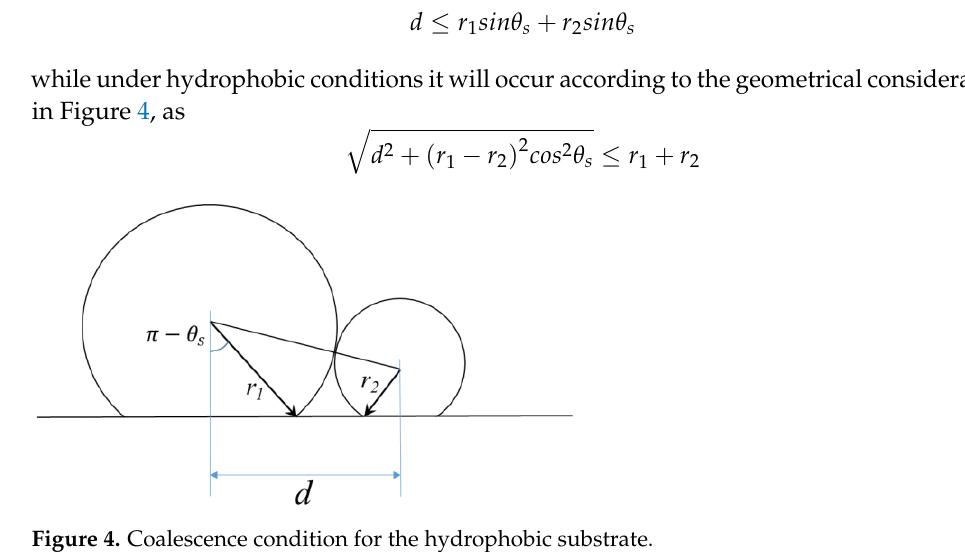
Figure 4. Coalescence condition for the hydrophobic substrate.